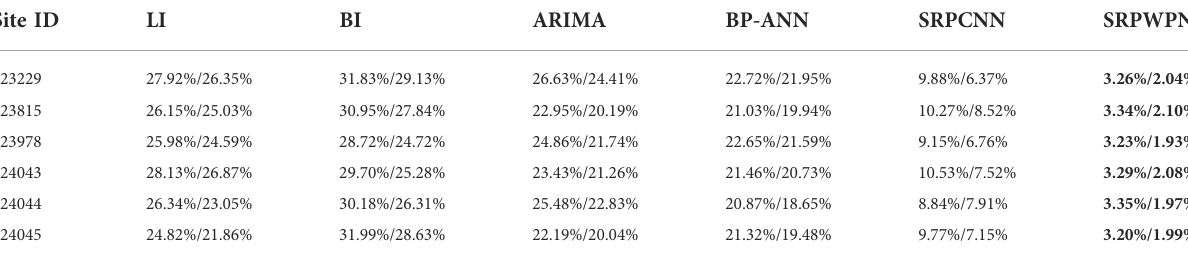
TABLE 2 Experimental results of different methods on NREL (MAPE on 15 min/10